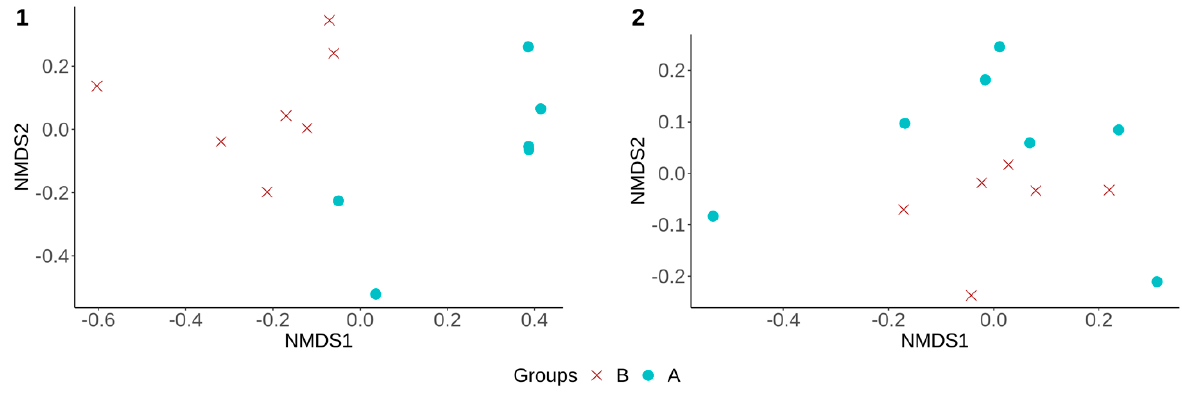
Figure 5. Non-metric multidimensional scaling (NMDS) using Bray–Curtis distance matrix. ( 1 ) Showed a significant difference ( p < 0.05, R 2 = 0.21) in the community structure (beta diversity) between group A and group B at Day 4 (same results were also observed at Day 7). ( 2 ) Showed no significant difference ( p > 0.05, R 2 = 0.1) in the community structure (beta diversity) between the same groups (A and B) at Day 36. A —challenged untreated group. B —challenged treated group.